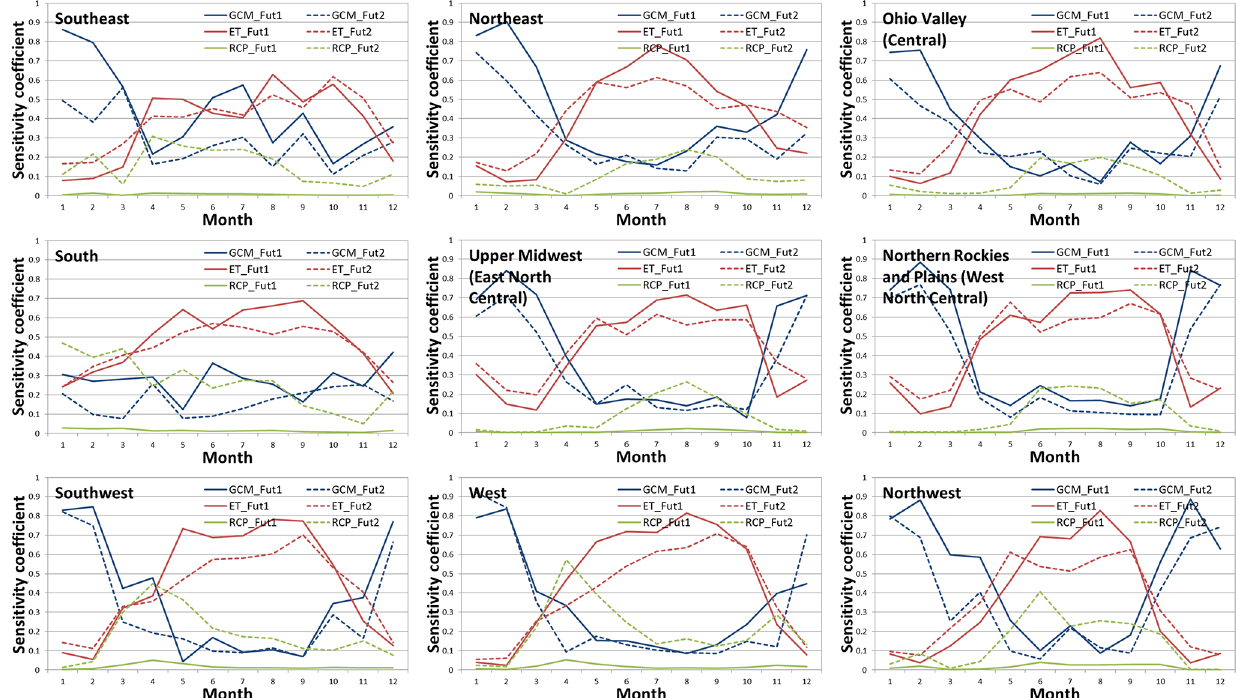
Figure 7. First-order sensitivity analysis results of change in P –ET 0 . Solid lines represent future period 1 (2030–2060) and dotted lines represent future period 2 (2070–2100). Blue lines represent the first-order effect of GCMs, red lines represent the first-order effect of ET 0 estimation methods, and green lines represent the first-order effect of